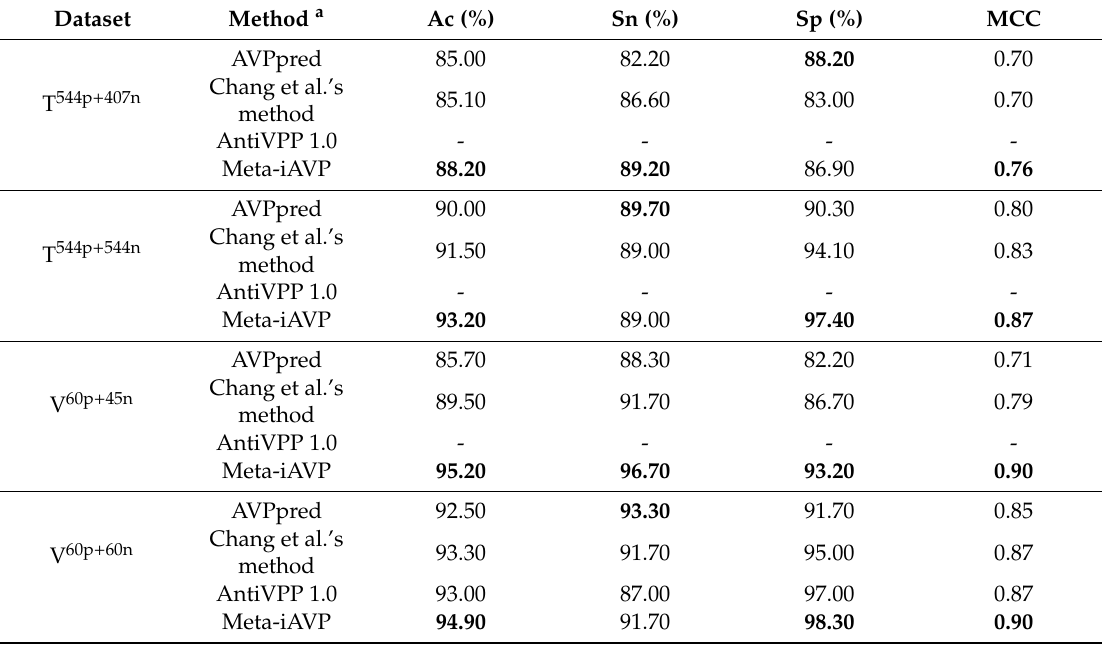
Table 5. Performance comparisons between Meta-iAVP and the three existing methods as assessed by the five-repeated five-fold cross-validation and independent validation